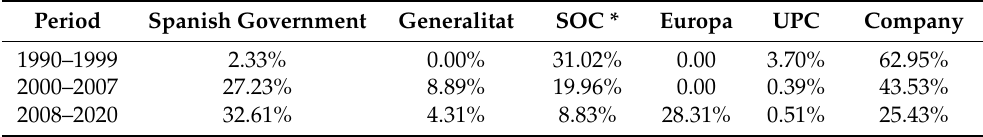
Table 11. Distribution of the source of SARTI financial